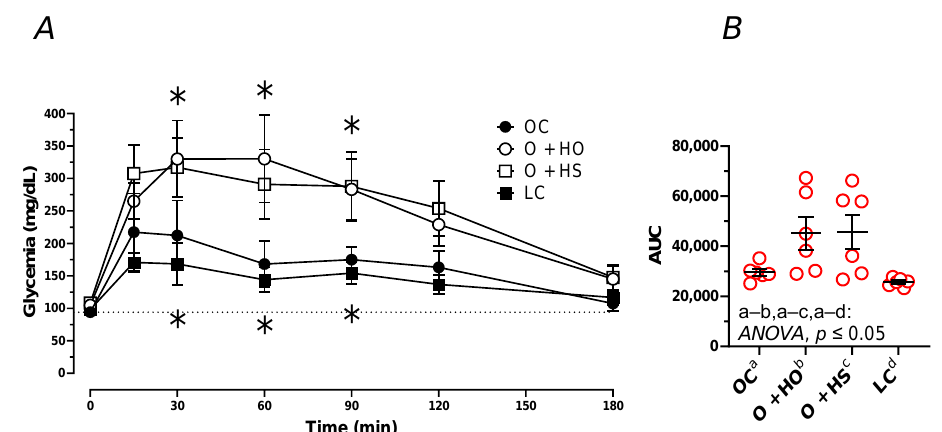
Figure 5. Oral glucose tolerance test (OGTT) of 8-week-old lean (LC) and obese (OC) Zucker rats fed a diet containing hemp seed oil (HO) and hemp seeds (HS) for 4 weeks. Values are means ± SD, n = 6, * p ≤ 0.05 vs. OC (two-way ANOVA) at 15, 30, 60, 90, 120, and 180 min ( A ), and as area under the curve—AUC ( B ). HO and HS did not ameliorate the impaired glucose tolerance test.